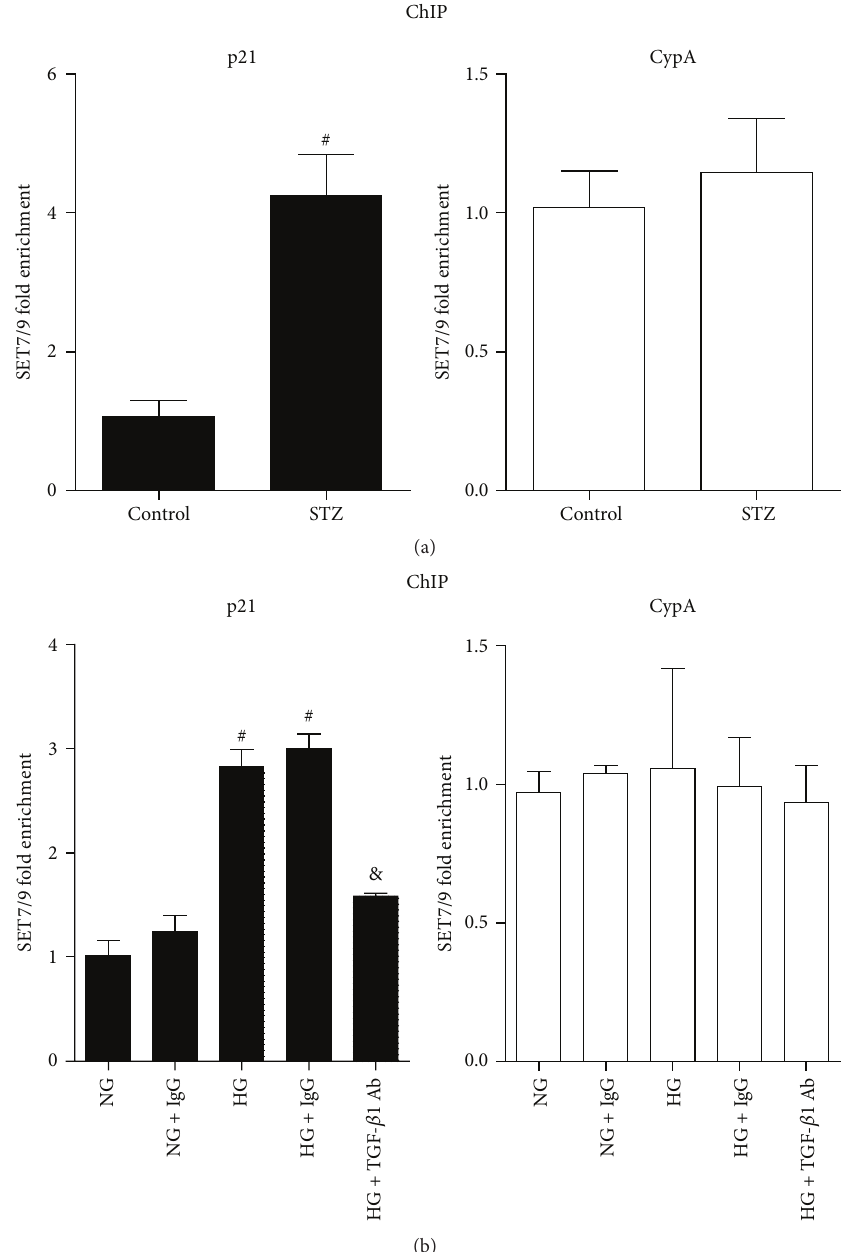
Figure 6: SET7/9 recruitment at p21 gene promoter was enhanced under diabetic conditions, and TGF- 𝛽 1-specific antibody could reverse HG-induced SET7/9 occupancy in RMCs. (a) SET7/9 recruitment at p21 and CypA gene promoters in glomeruli of control and STZ groups. ChIP assays were performed and results were expressed as described in Materials and Methods (mean ± SEM; # 𝑃 < 0.05 compared to control). (b) Reversion of HG-induced SET7/9 enrichment at p21 promoter by TGF- 𝛽 1-specific antibody. ChIP assays were performed and results were expressed as described in Materials and Methods (mean ± SEM; # 𝑃 < 0.05 compared to NG; & 𝑃 < 0.05 compared to HG, 𝑛 = 3